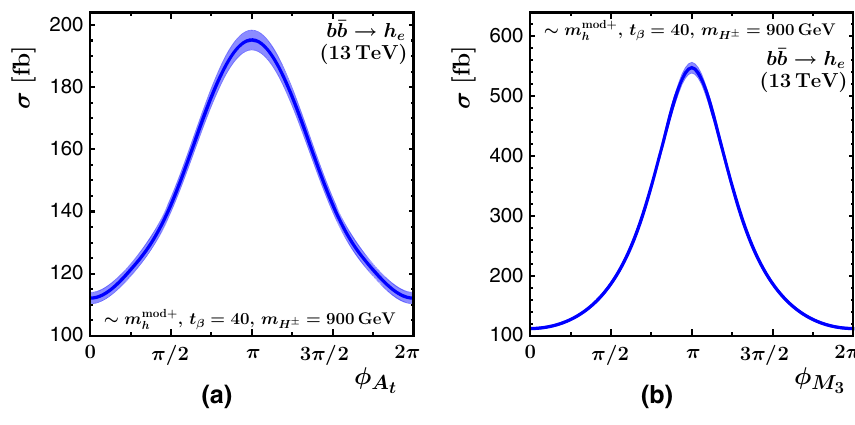
Fig. 10 Bottom-quark annihilation cross section for h e in fb as a function of a φ A and t b φ M in the m mod + -inspired h 3 scenario with tan β = 40.